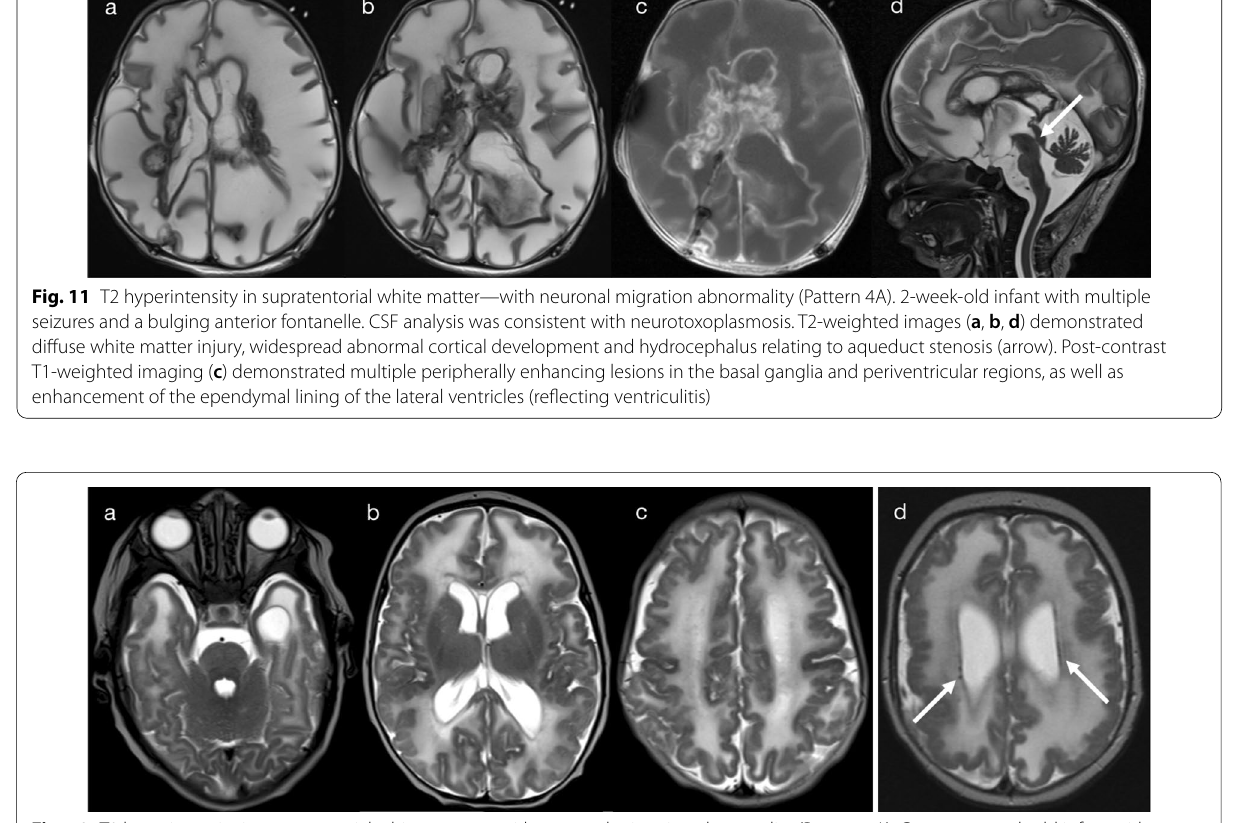
Fig. 12 T2 hyperintensity in supratentorial white matter—with neuronal migration abnormality (Pattern 4A). Case 1: 11‑week‑old infant with bilateral sensorineural hearing loss on newborn testing. Guthrie test was positive for CMV. T2‑weighted imaging ( a – c ) demonstrated polymicrogyria with diffuse white matter hyperintensity and cystic change in the left anterior temporal pole. Clinical notes at 14 months of age indicated developmental delay. Case 2: 4‑month‑old infant with microcephaly, developmental delay and hypertonia under investigation. Guthrie test was positive for CMV. T2‑weighted imaging ( d ) demonstrated polymicrogyria with diffuse white matter hyperintensity and subtle periventricular calcifications